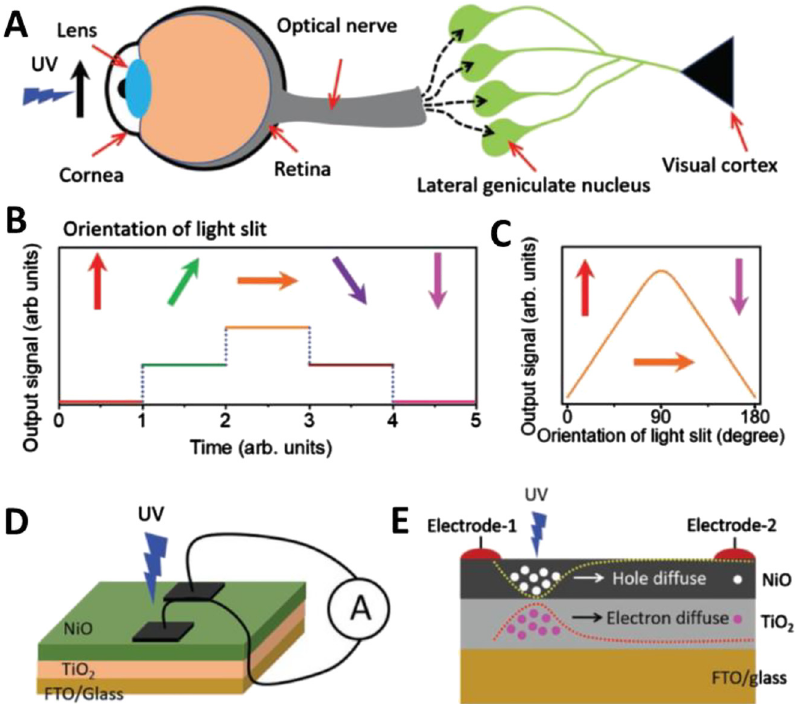
Figure 9: (A) Scheme of the operation of the human eye. (B) Variation in the